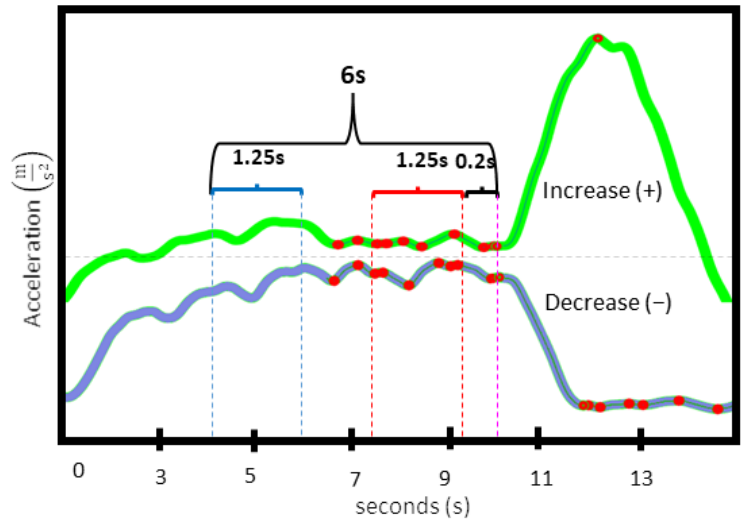
Figure 3. Example of the selected processing windows used for offline validation and classification model creation. The figure shows a 15 seconds segment of the IMUs signal filtered and processed from Subject 2. Increase (+) shows the signal in a positive acceleration repetition. Decrease ( − ) shows the signal in a negative acceleration repetition. The pink dotted line marks the labeled point of change, the blue window marks the normal walking window class and the red window shows the class labeled as change of speed. The IMUs information was used to create the BMI prediction model for E1 and E2 labeling the different class